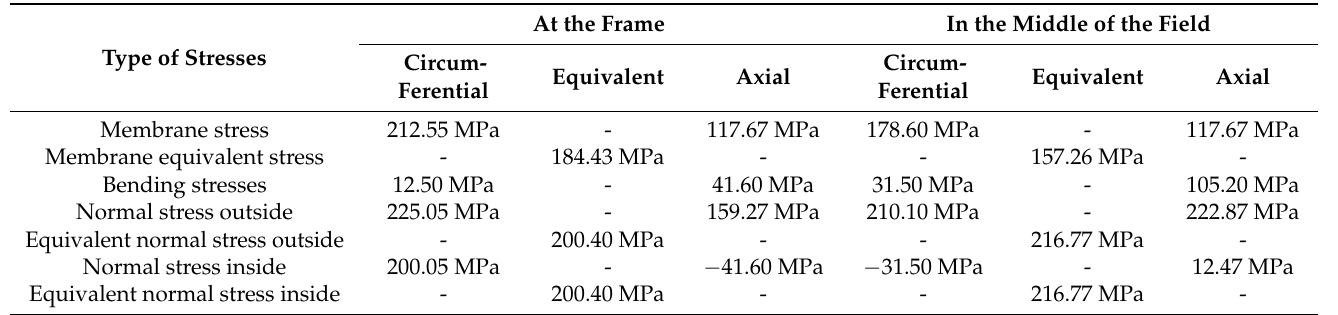
Table A3. Stresses in the free flooding compartment (test diving depth) for SST 1: Subsea shuttle tanker (Cargo 10,569 m 3 ).